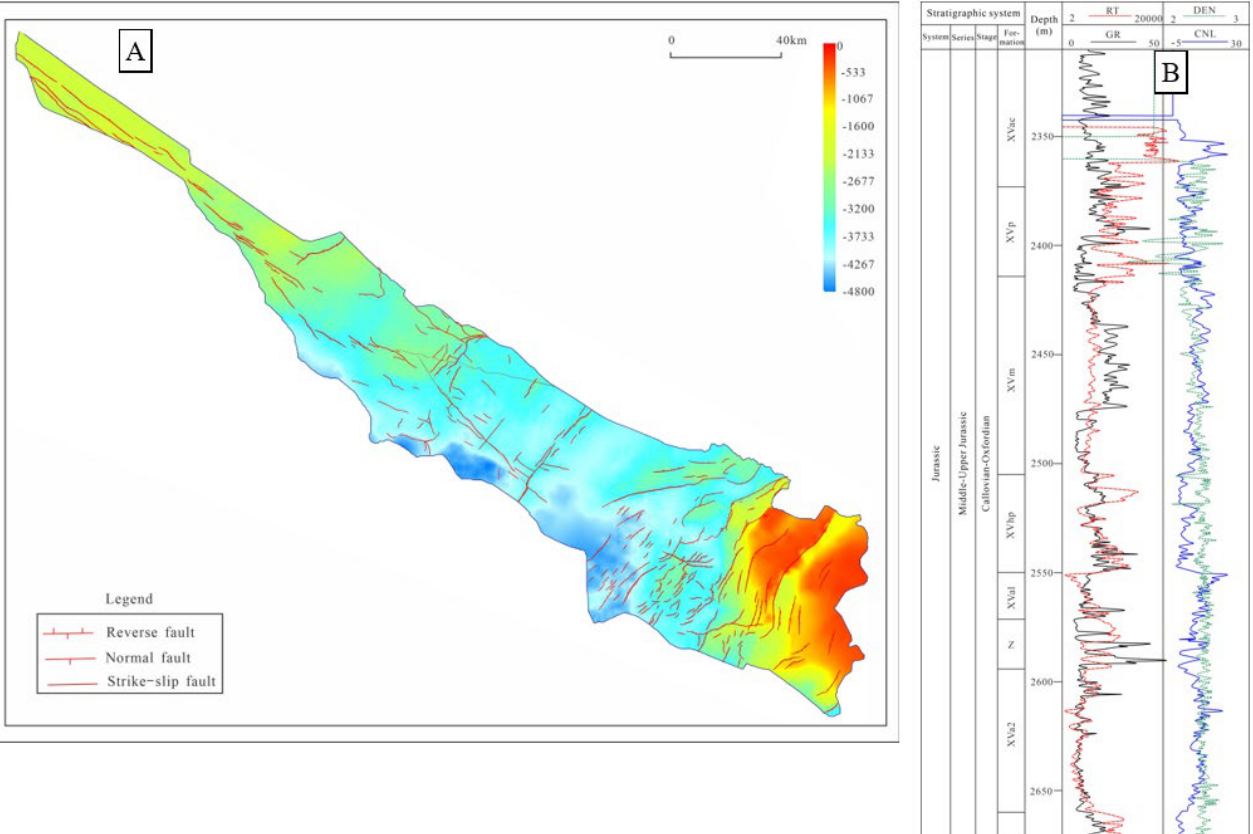
Figure 2. ( A ) Structure map (carbonate top) of the study area. ( B ) Target intervals and the log characteristics of Callovian–Oxfordian.